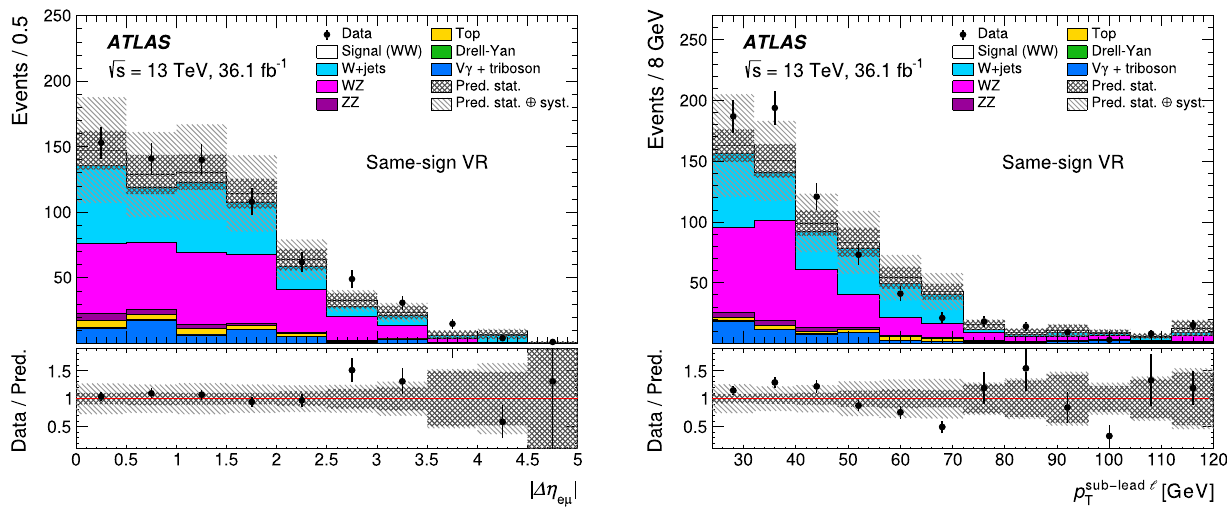
Fig. 3 Distributions of the pseudorapidity difference between the leptons (left) and the transverse momentum of the sub-leading lepton (right) for the same-sign validation region. The uncertainties shown include statistical and systematic uncertainties